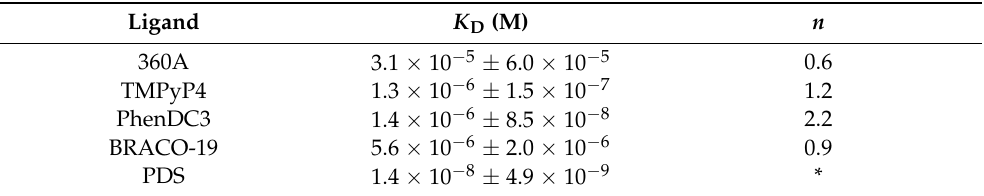
Figure 6. Fluorescence titration spectra of pre- folded 5′ -Cy5-AT11-L2 G4 with increasing concentra- tions of ( A ) 360A, ( B ) TMPyP4, ( C ) PhenDC3, ( D ) BRACO-19 and ( E ) PDS. The experiments were performed in buffer containing 10 mM of lithium cacodylate and 100 mM of KCl with excitation set at 647 nm, and emission was recorded ranging from 655 to 800 nm. Table 2. Apparent dissociation constants ( K D ) of pre- folded 5′ -Cy5-AT11-L2 G4 in the presence of the tested ligands obtained by fluorescence titrations.